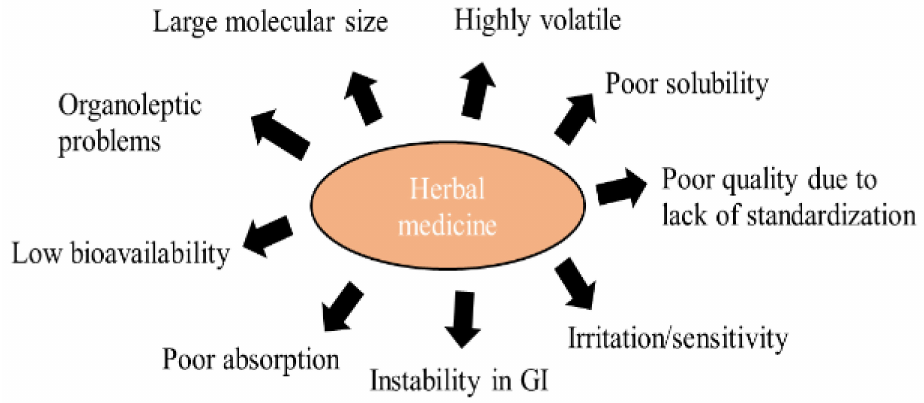
Figure 1. Limitations of herbal medicines restricting application in dental